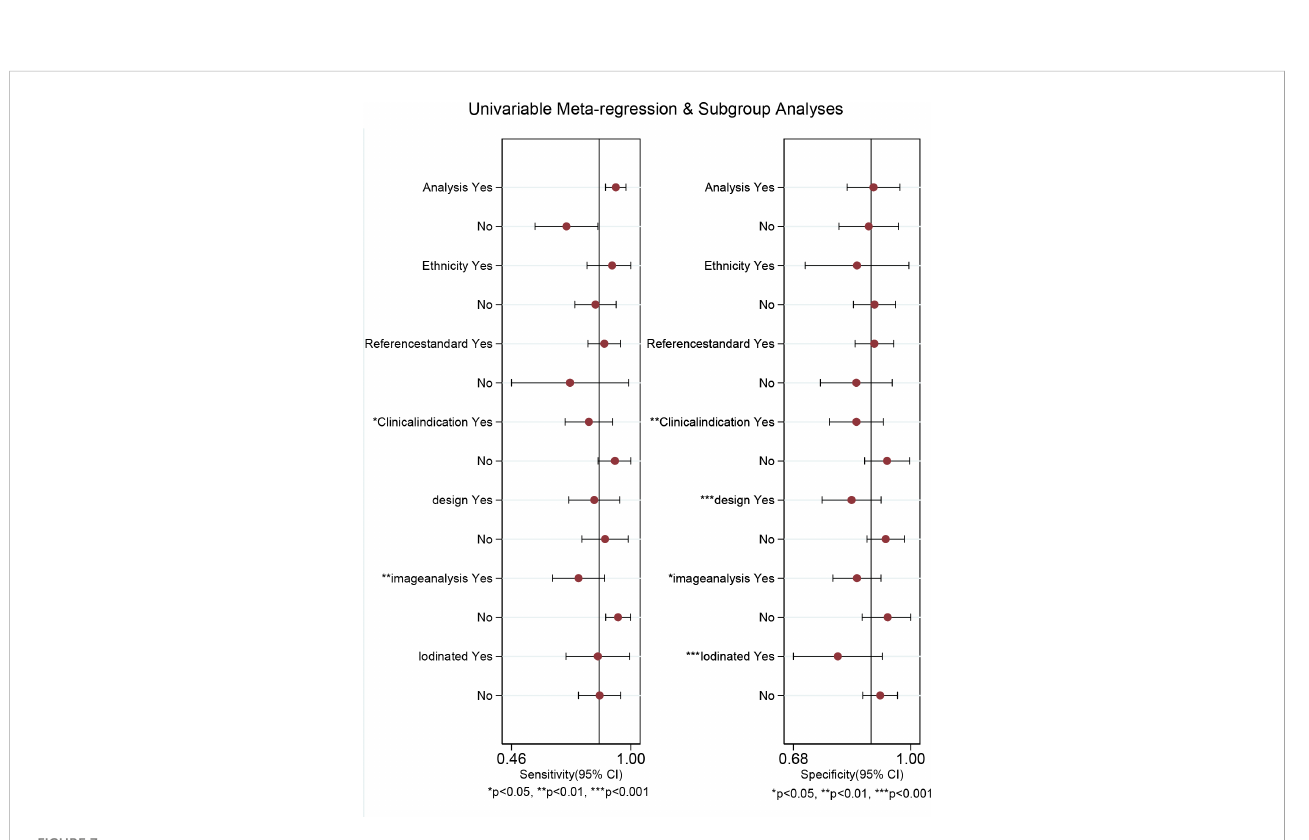
FIGURE 7 Multiple univariable meta-regression forest plot of [18F]FDG PET/CT for colorectal liver